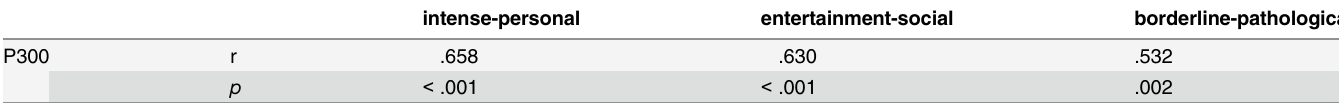
Table 1. Correlation indexes and p values between the three CAS dimensions (intense-personal, entertainment-social and borderline-pathologi- cal) and average voltages of P300.